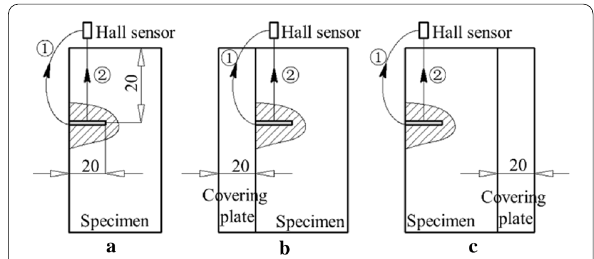
Figure 13 The possible leakage paths in the MFL experiment (Side view in Figure 10)